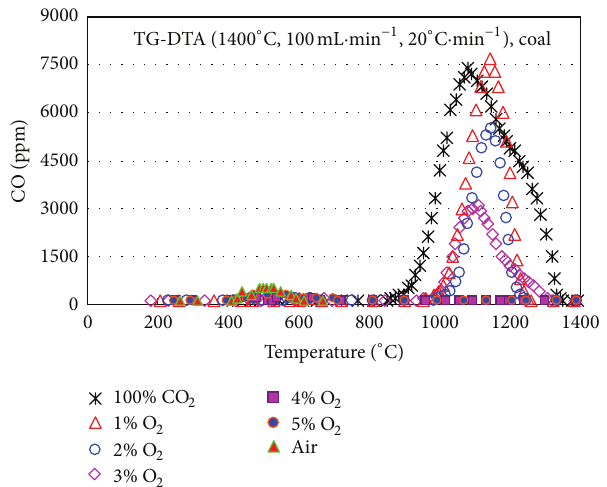
Figure 22: CO gas generation of coal in air and CO 2 -rich gas flows.